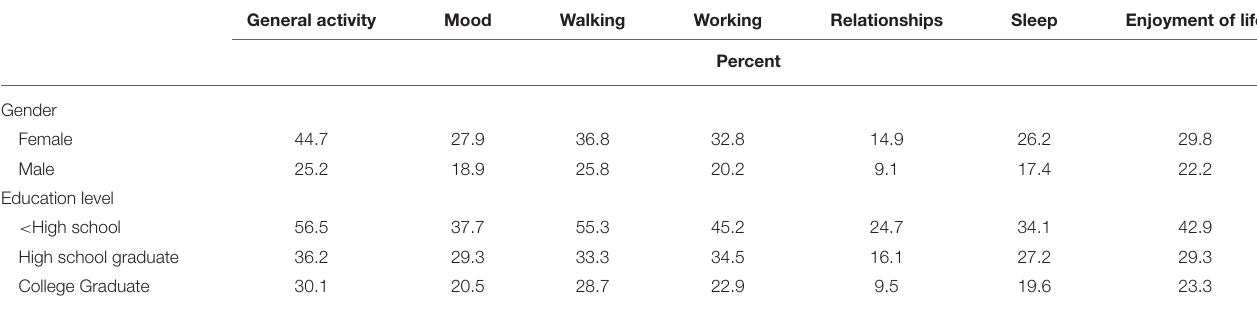
TABLE 3 | Prevalence of moderate to severe pain interference by domains according to gender and education in older adults *